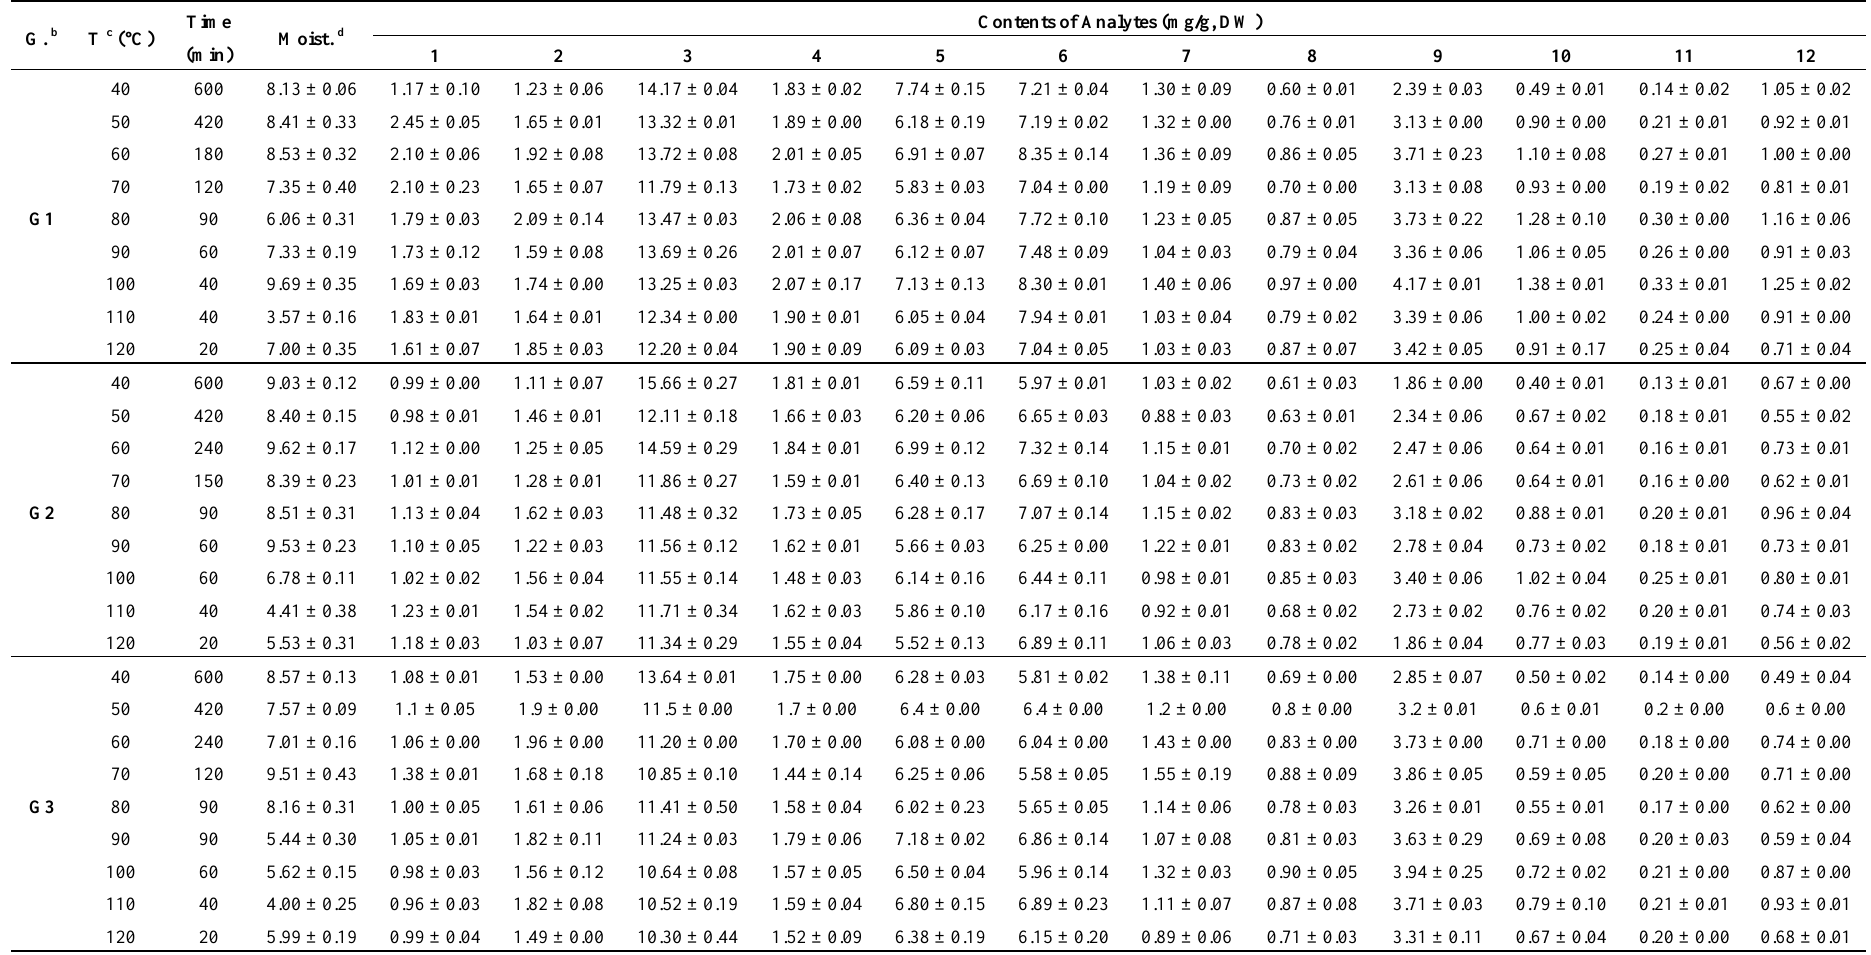
Table 1. Efficiencies and levels of twelve analytes in dried samples with standard moisture.